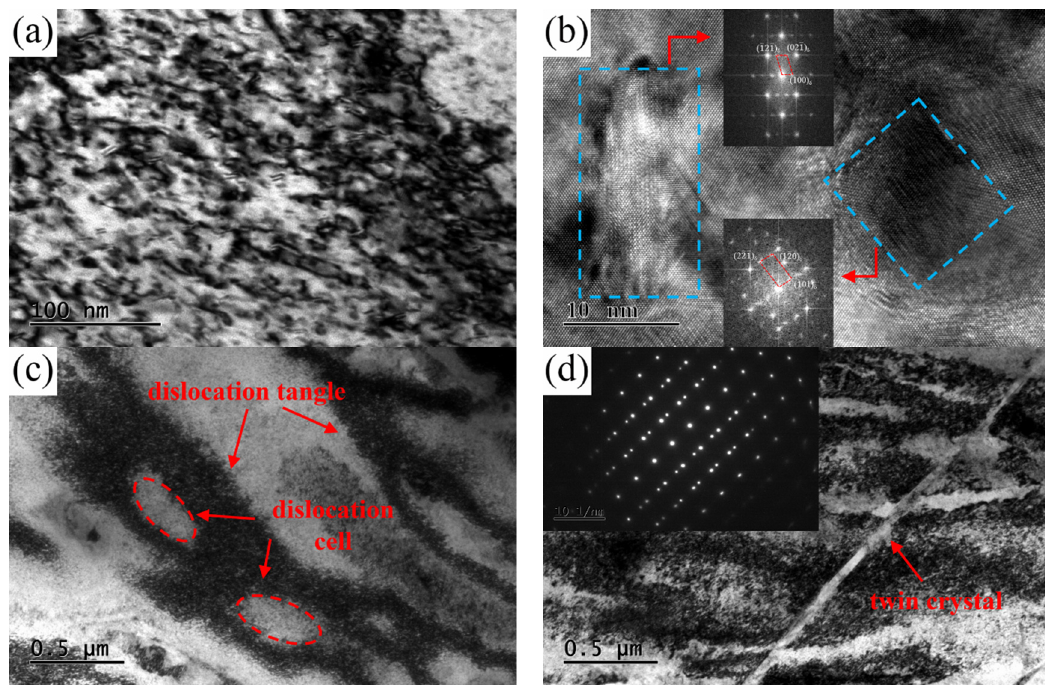
Figure 13. TEM images of the NS-4 alloy with heat treatment of TP-e. ( a ) Bright-field TEM image along [110] Cu , ( b ) HRTEM image, ( c ) dislocation tangles and cells, and ( d ) deformation twins and the corresponding SAED image.